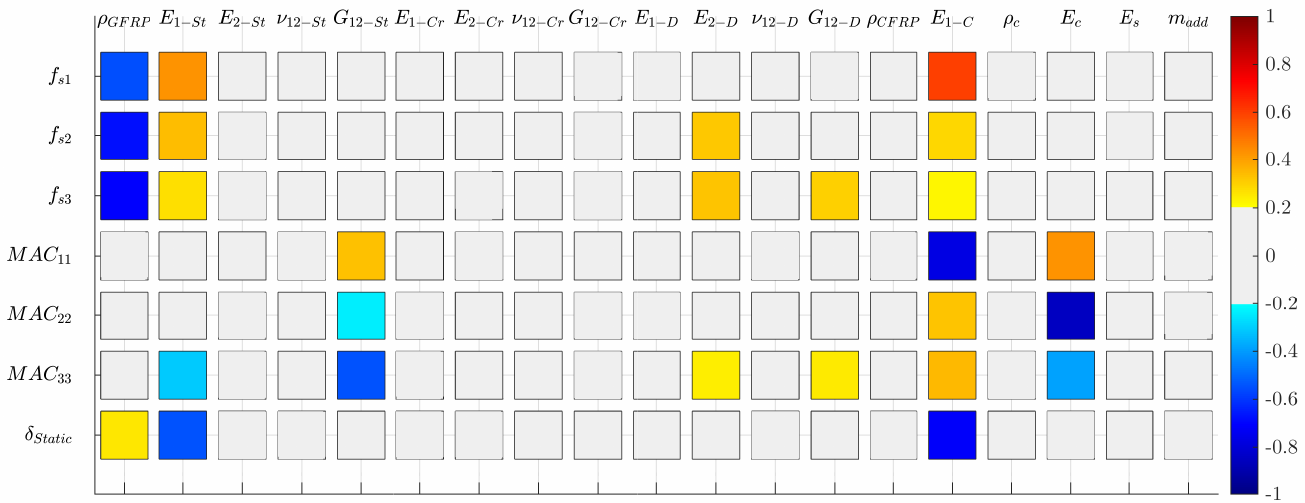
Figure 8. Spearman correlation matrix between the parameters of the FE model and the responses of the FRP